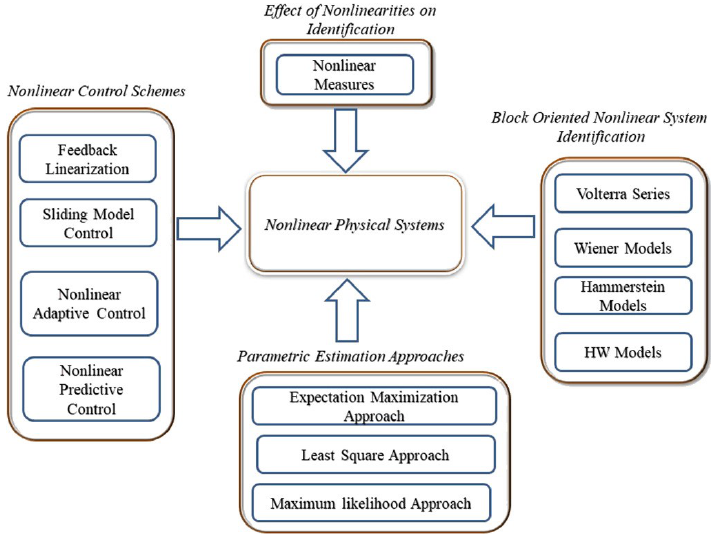
Fig. 1 Memoryless nonlinear transformation